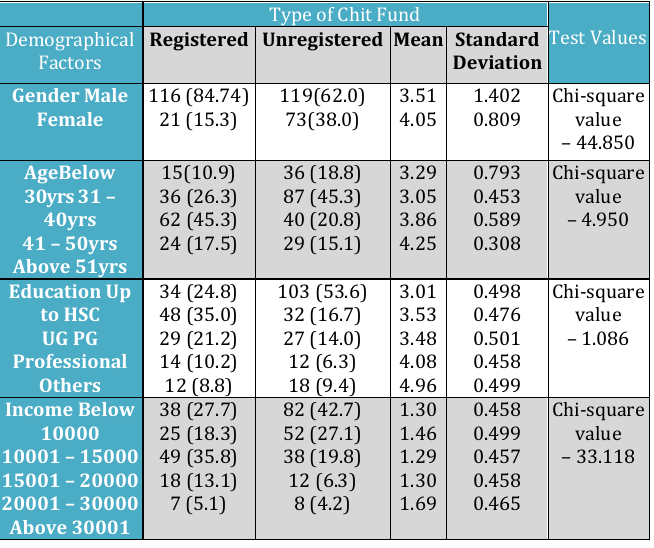
Table 4: Demographical factors verses type of chit funds Type of Chit